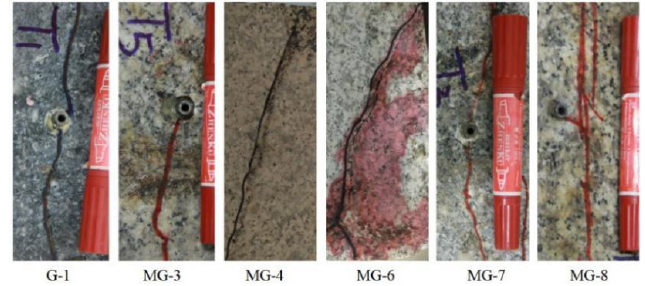
Figure 15. Geometric characteristics of the cracks in the samples after fracturing.